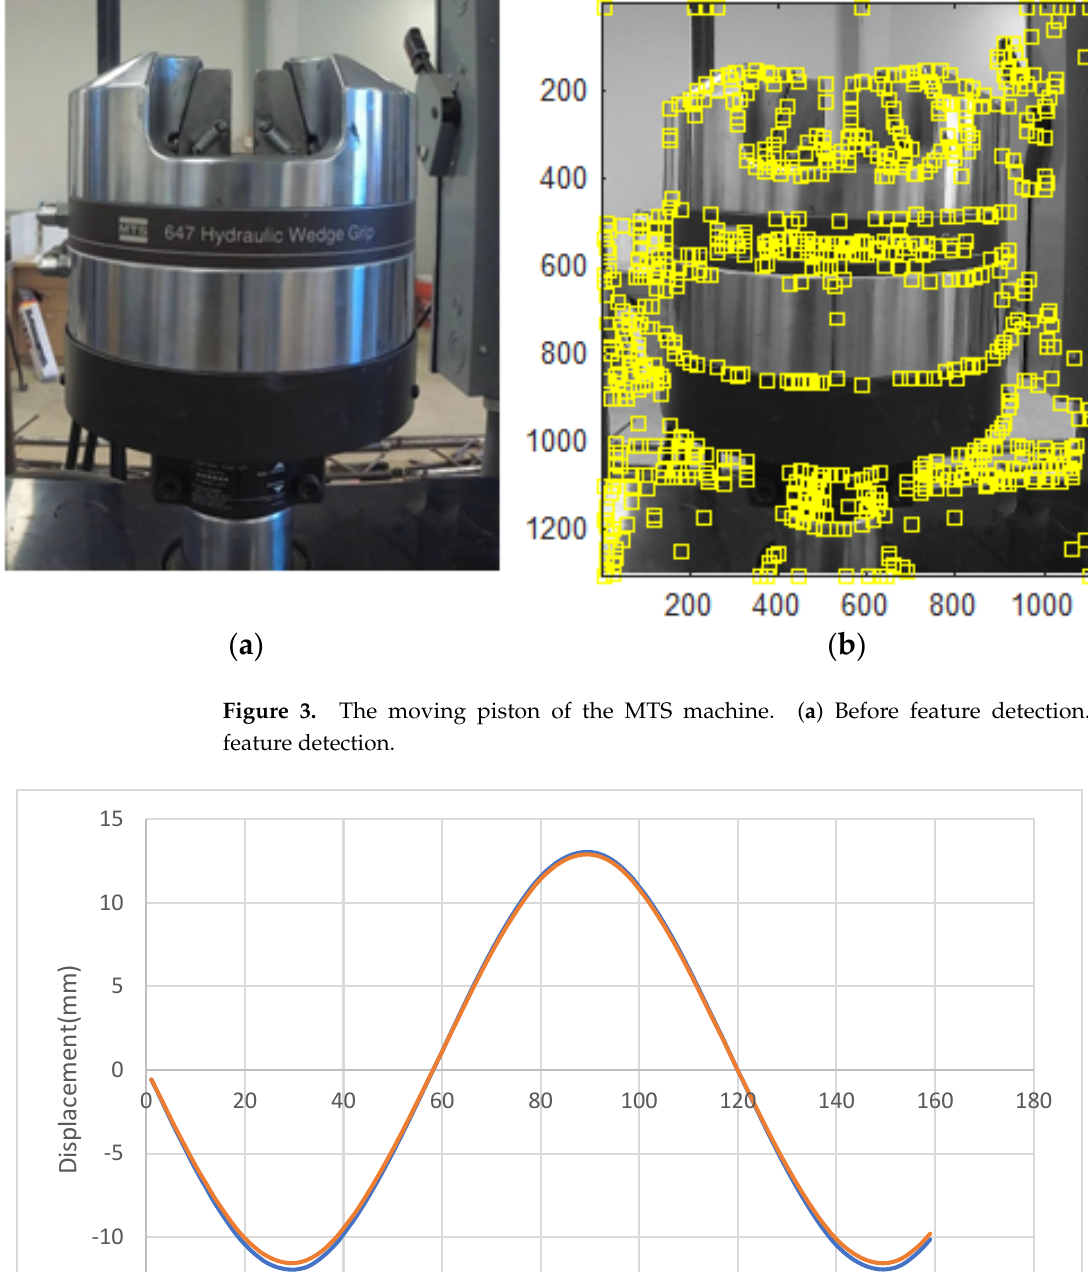
Table 4. Accuracy of the traditional LK method with respect to the MTS movements. POI